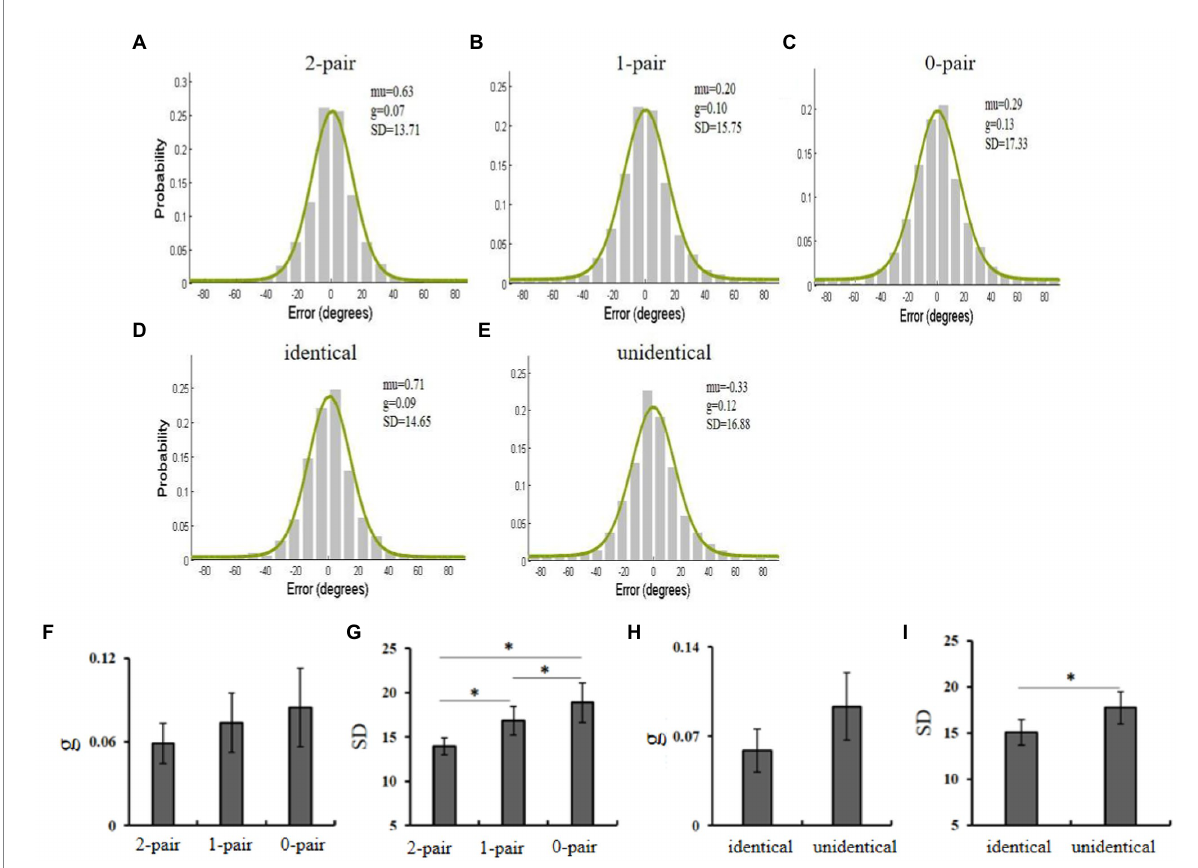
FIGURE 2 (A–C) Distributions of response errors with the fit of standard mixture model in the condition with two pairs of identical objects (2-pair), one pair of identical objects (1-pair), and no pair of identical objects (0-pair). (D,E) The distributions of response errors for the identical items and unidentical items in the 1-pair condition. (F,G) The guess rate and SD in the three conditions. (H,I) The guess rate and SD for the identical items and unidentical items in the 1-pair condition. The black bars represent the standard